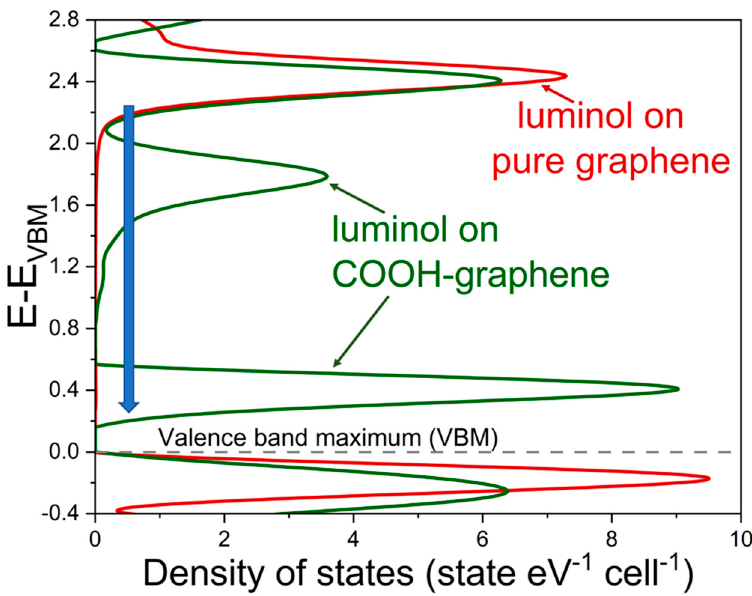
Figure 2. A comparison between the pDOS of luminol adsorbed to pure graphene and to COOH- graphene with a significant decrease in the LUMO indicated by the blue arrow.